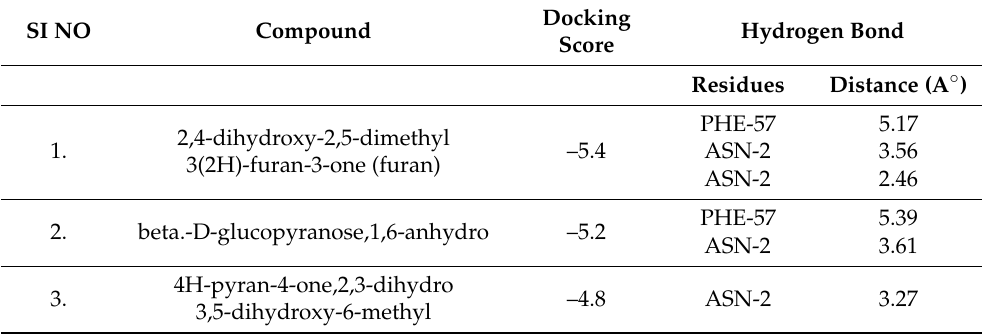
Table 5. The protein–ligand interaction and identification of binding